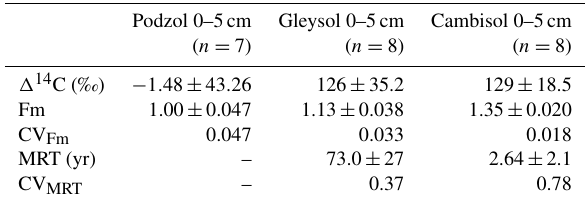
Table 3. Intra-plot variability for three spatial variability end- members, expressed in (cid:49) 14 C and standard deviation across regions and horizons converted to mean residence time (MRT) and coeffi- cient of variation (CV). Variability is the highest for the Podzol and Gleysol, and lowest for the